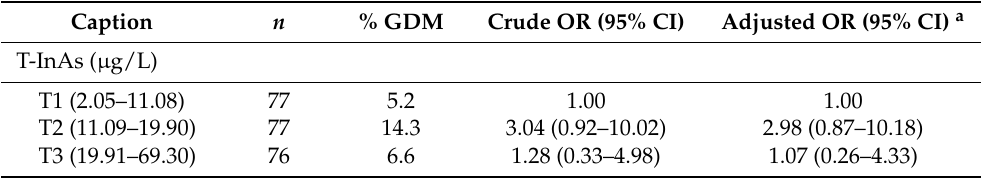
Table 3. Crude and adjusted association between the concentration of total inorganic arsenic in urine and gestational diabetes, Arica